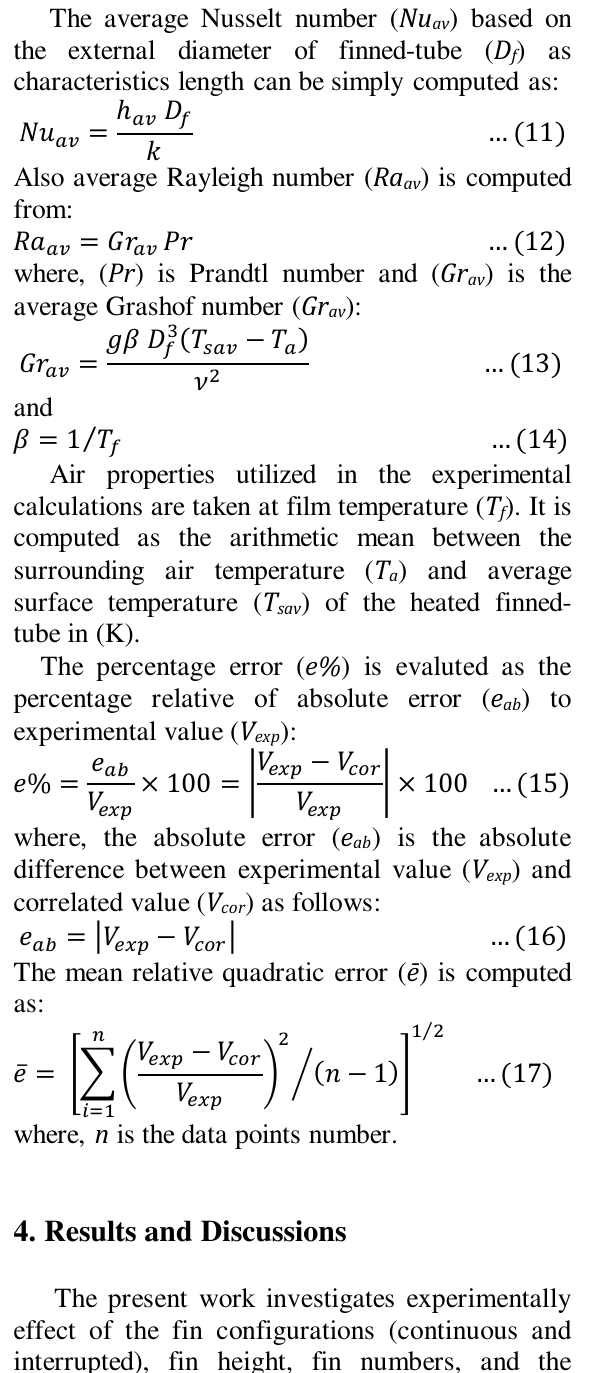
temperatures temperatures